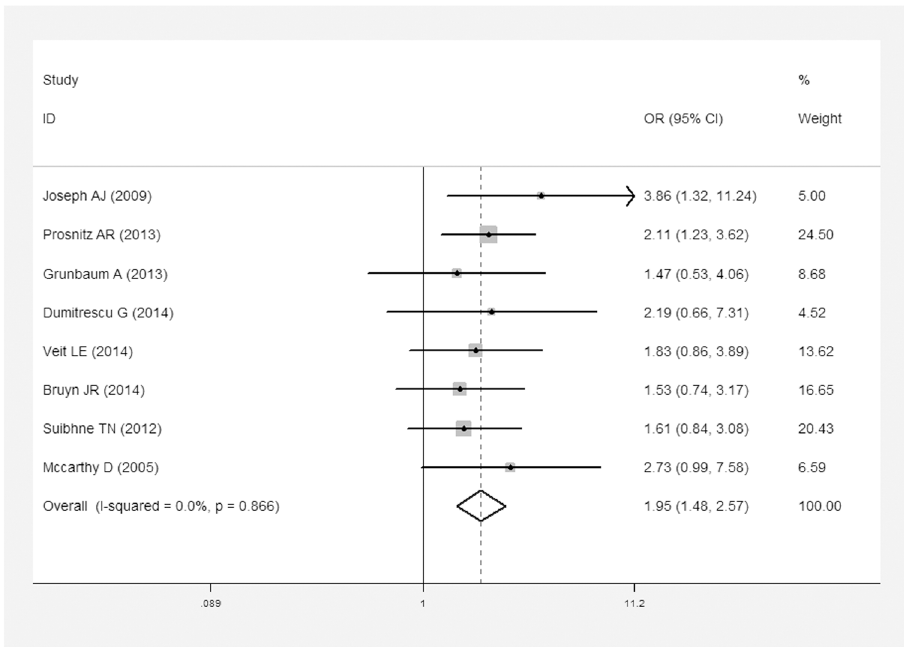
Fig 4. Meta-analysis of studies reporting dichotomous outcomes of 25(OH)D levels in CD patients vs. controls and estimated OR with a 95% confidence interval and weight percentage.